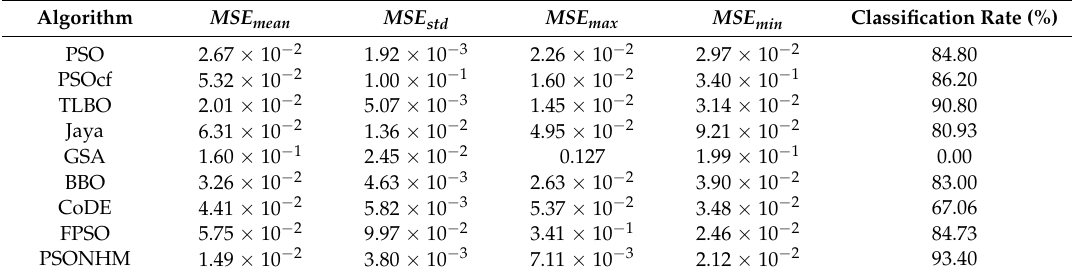
Table 7. Experimental results for the Iris dataset.